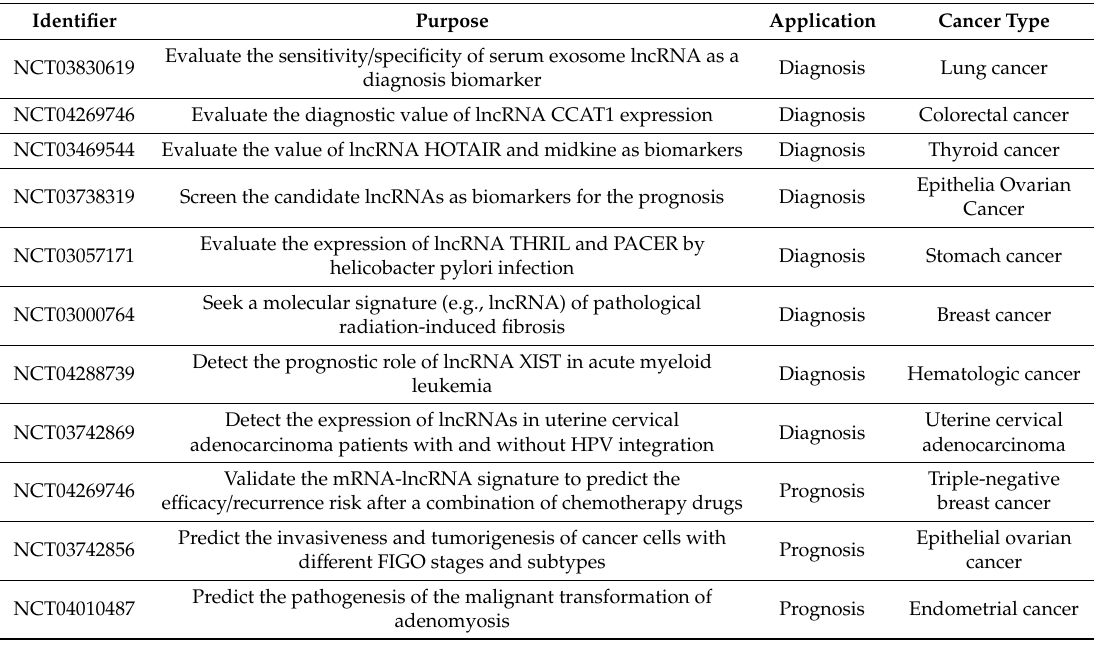
Table 6. Application of LncRNAs in clinical